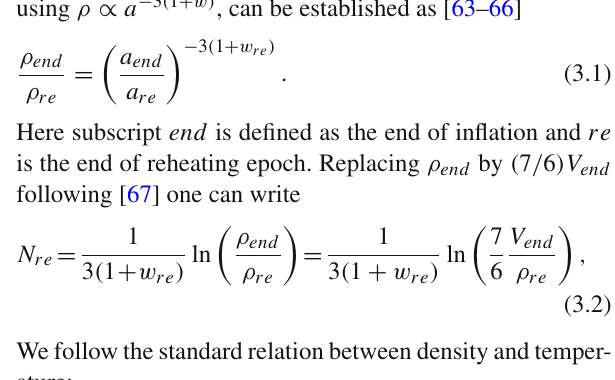
The light pink shaded region corresponds to the 1- σ bound and the yellow shaded region is 2- σ bound on n s from Planck’18 [TT,TE, EE+lowE+lensing+BK15]. The dark pink shaded region corresponds to the 1- σ bound of future CMB observations using same central value for n s